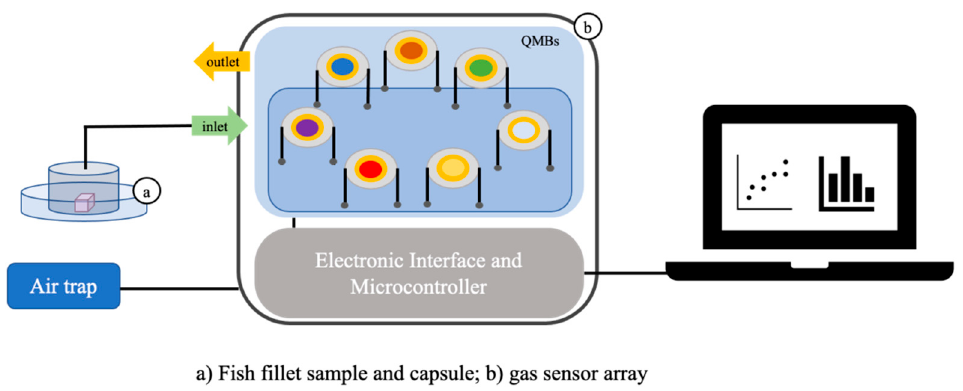
Figure 2. Experimental set-up of the fish headspace measurement via BIONOTE-V.